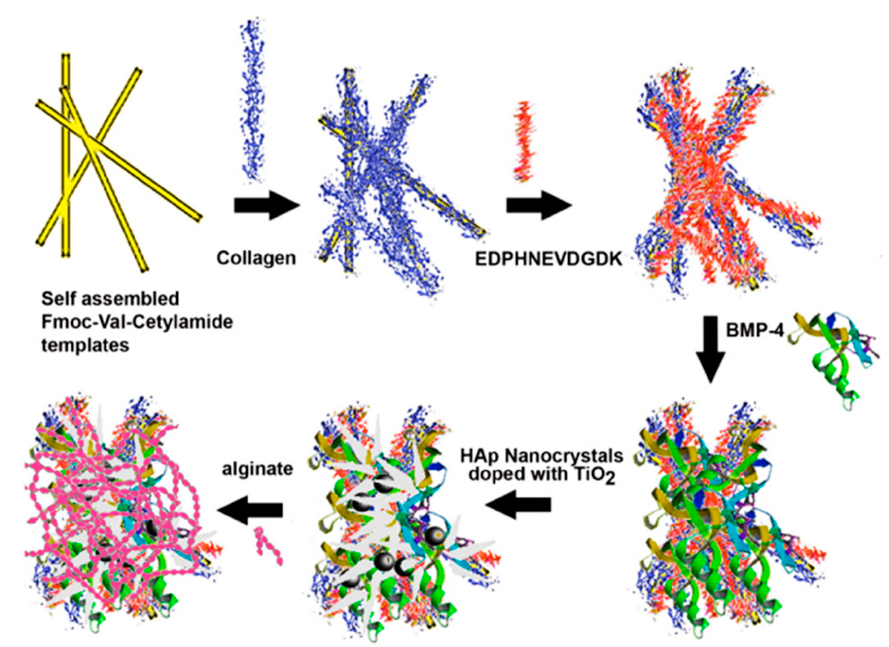
Figure 15. Scheme showing the preparation of 9-fluorenylmethyloxycarbonyl (Fmoc)-Val-cetylamide- collagen-DT–BMP-4 biocomposites by layer-by-layer (LBL) assembly. The assemblies were finally coated with 1% alginate to form scaffolds for bone tissue regeneration. Reproduced from [179].